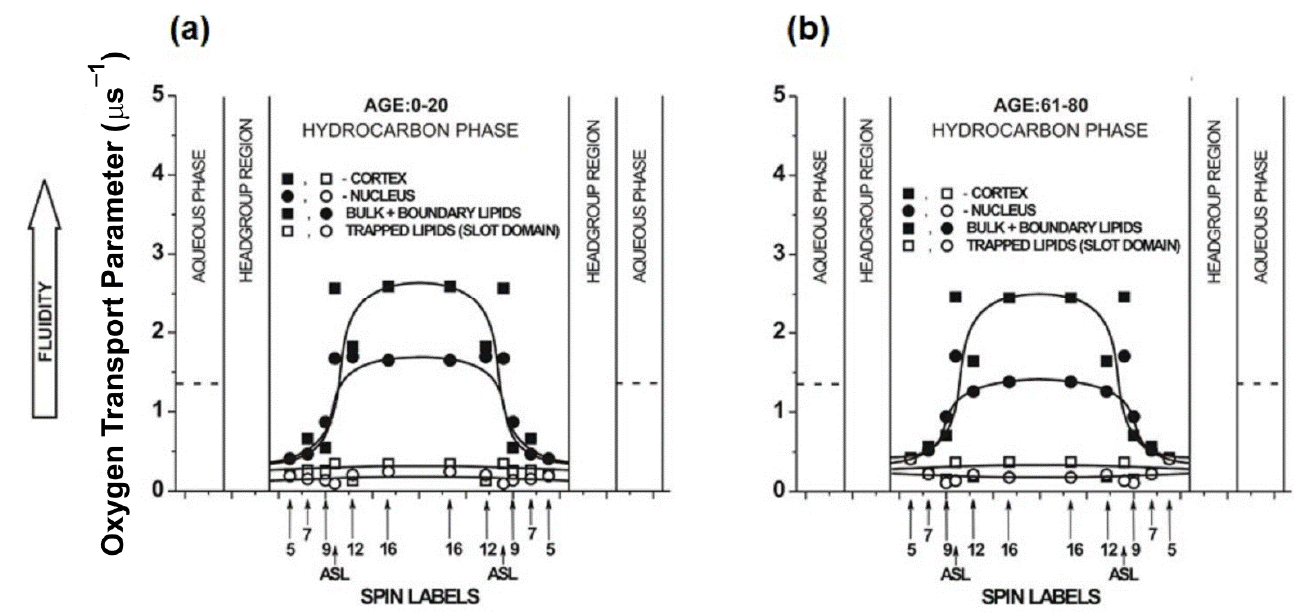
Figure 8. ( a ) Profiles of the OTP across domains in intact cortical ( ■ , □ ) and nuclear ( ● , ○ ) fiber cell plasma membranes of eye lenses from 0–20- and 61–80-year-old human donor groups. All profiles were obtained at 37 °C. Profiles obtained with n-SASLs are not contaminated by the presence of CBDs. ( b ) Profiles are reported for bulk plus boundary lipids ( ■ , ● ) and for trapped lipids ( □ , ○ ). Values obtained with ASL in domains of cortical and nuclear membranes are also included. Ap- proximate localizations of the nitroxide moieties of spin labels are indicated by arrows. The OTP value in water is shown by dotted lines. Figure 8 is reproduced from [68]. Copyright 2022, with permission from Elsevier.